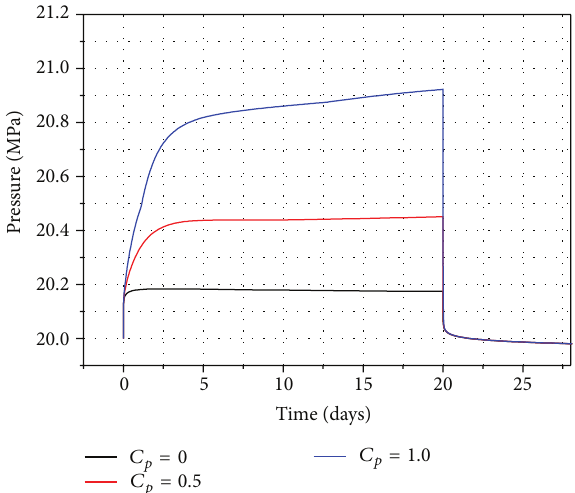
Table 3: Relation between polymer concentration and water phase viscosity.